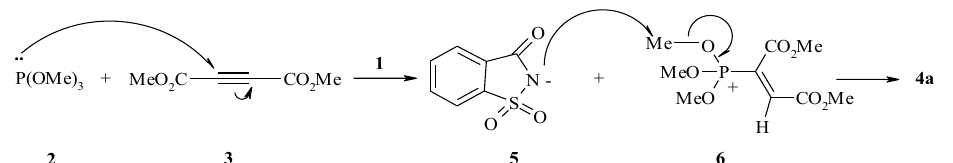
Figure 2. Suggested mechanism for formation of compound